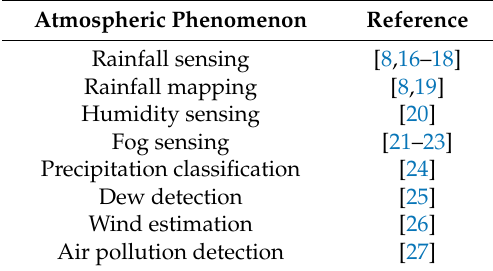
Table 2. Demonstrations of capabilities.